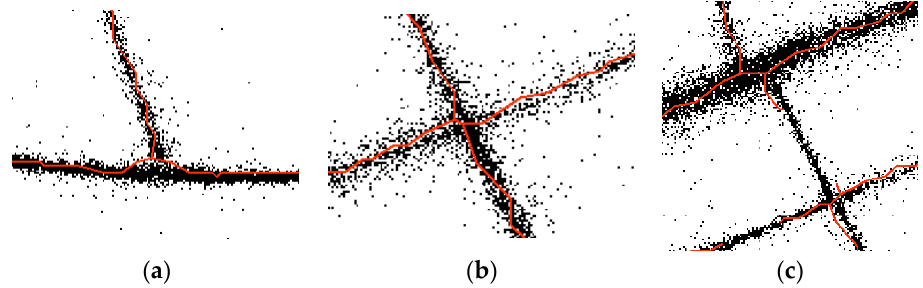
Figure 1. Intersections position deviation, and road segments around intersections are distorted and broken: ( a ) Position deviation; ( b ) distorted road segments; ( c ) broken road segments.